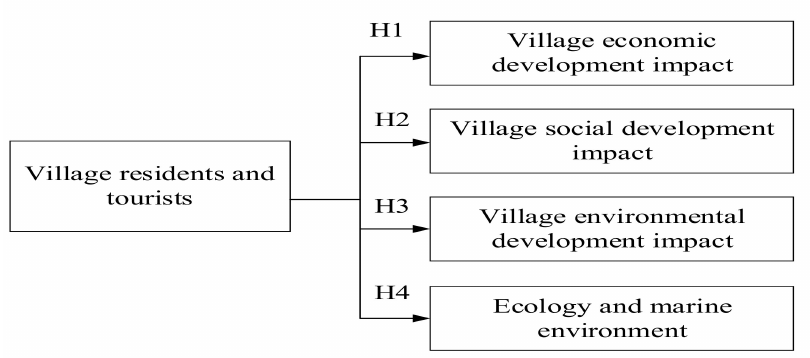
Figure 1. Research framework.